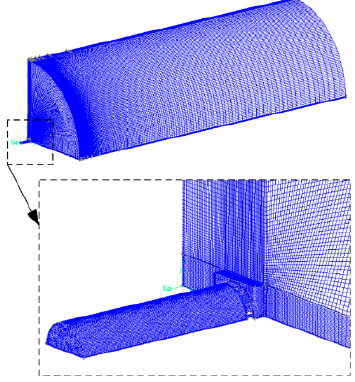
Figure 3. Computational domain of the dual parallel jet with porous nozzles.